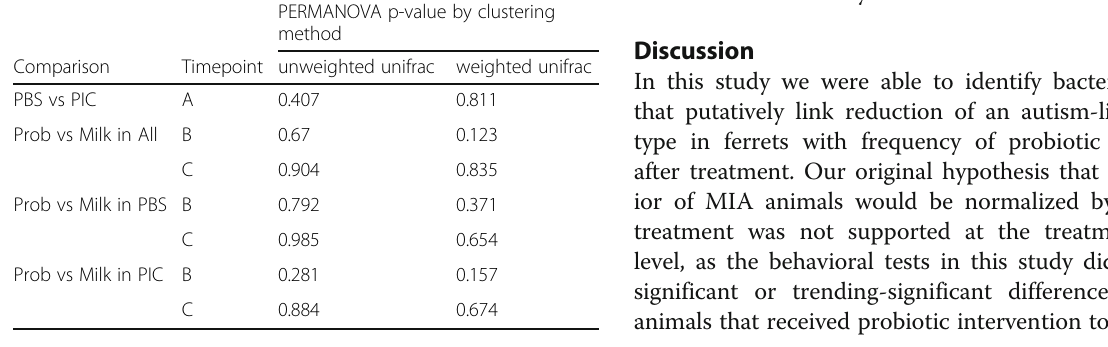
PERMANOVA p-value by clustering